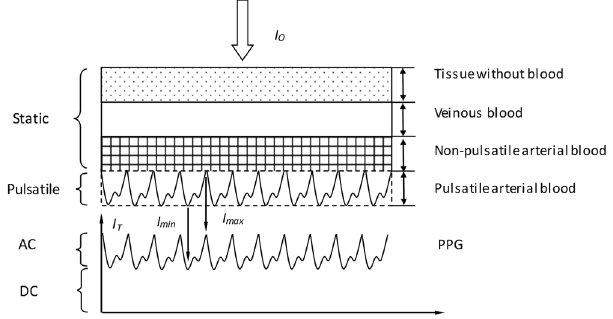
Figure 1. The principal of dynamic spectrum. A simplified model of tissue is shown and the tissue can be regarded as a combination of a pulsatile part and a static part. So, the PPG waveform consists of two parts: AC (pulsatile) and DC (baseline) 49,54,55 . I T represents transmitted light intensity and t represents